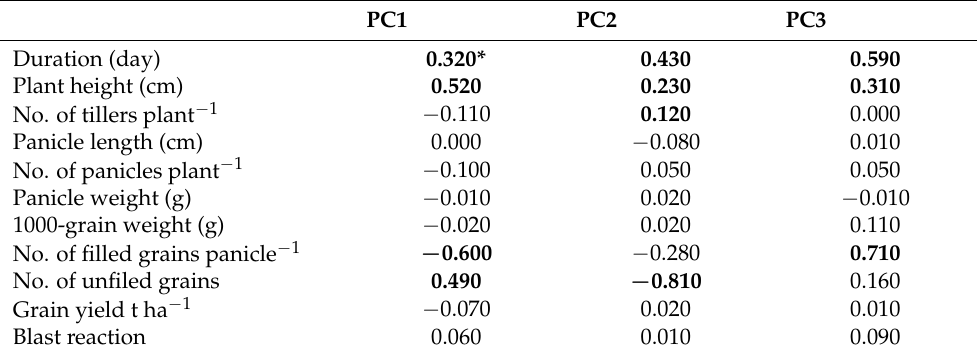
Table 6. First three principal components and their loadings of 11 agro-morphological traits of the 12 rice